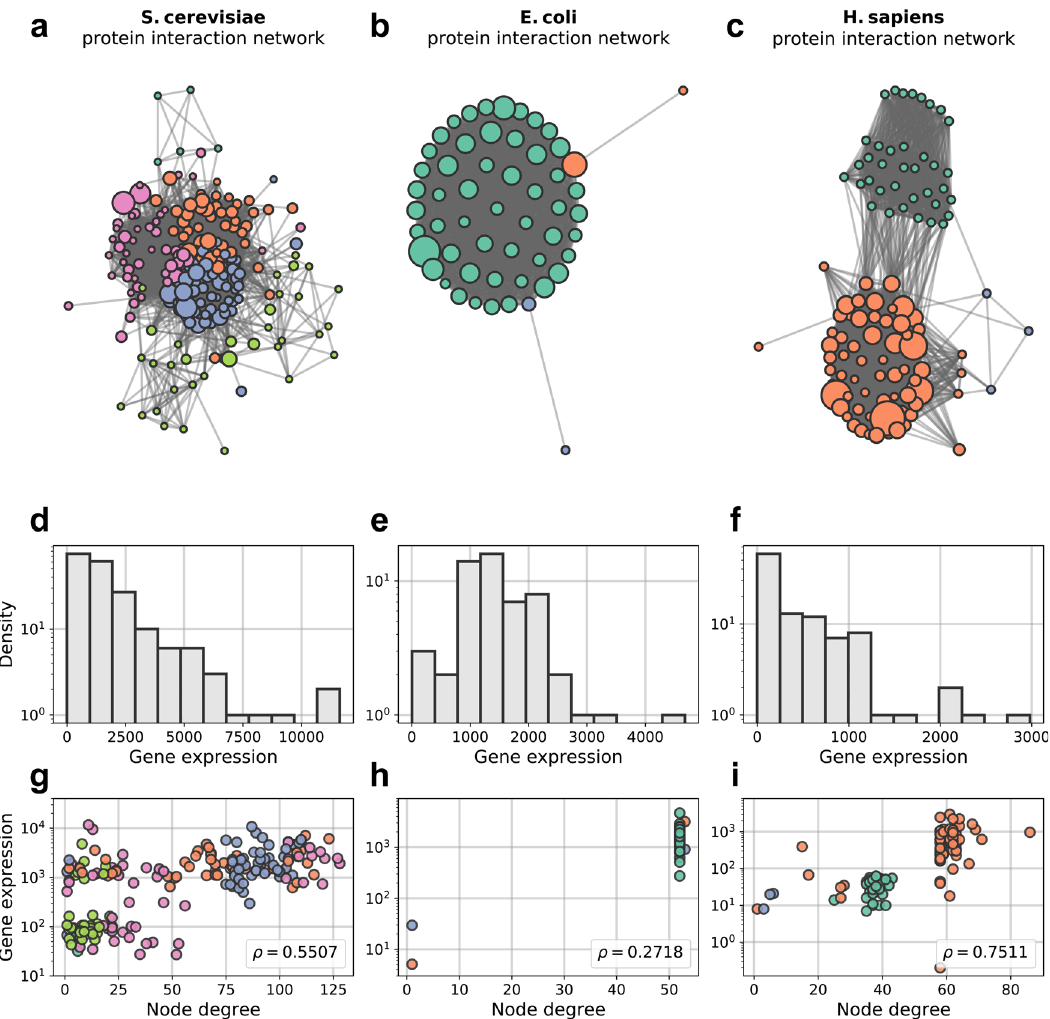
Fig. 2 Ribosomal networks. These species have ribosomal interaction networks that span a range of different network structures. Node colors depict detected communities in the networks. Nodes of a given color are more likely to connect to other nodes of that color. Node size is proportional to gene expression. a S. cerevisiae ribosomal network. b E. coli ribsomoal network. c H. sapiens ribosomal network. d – f Gene expression distribution of ribosomal networks for S. cerevisiae , E. coli , and H. sapiens respectively. g – i Gene expression (in transcripts per million, TPM) plotted against node degree for ( S. cerevisiae , E. coli , H. sapiens ), respectively. To accentuate clusters of nodes that share degree and gene expression attributes, the points in these plots share the same color as their corresponding nodes in ( a – c ). Node size is not included here to improve